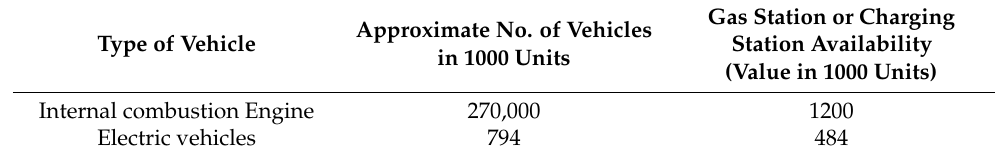
Table 5. Charging and refueling stations.